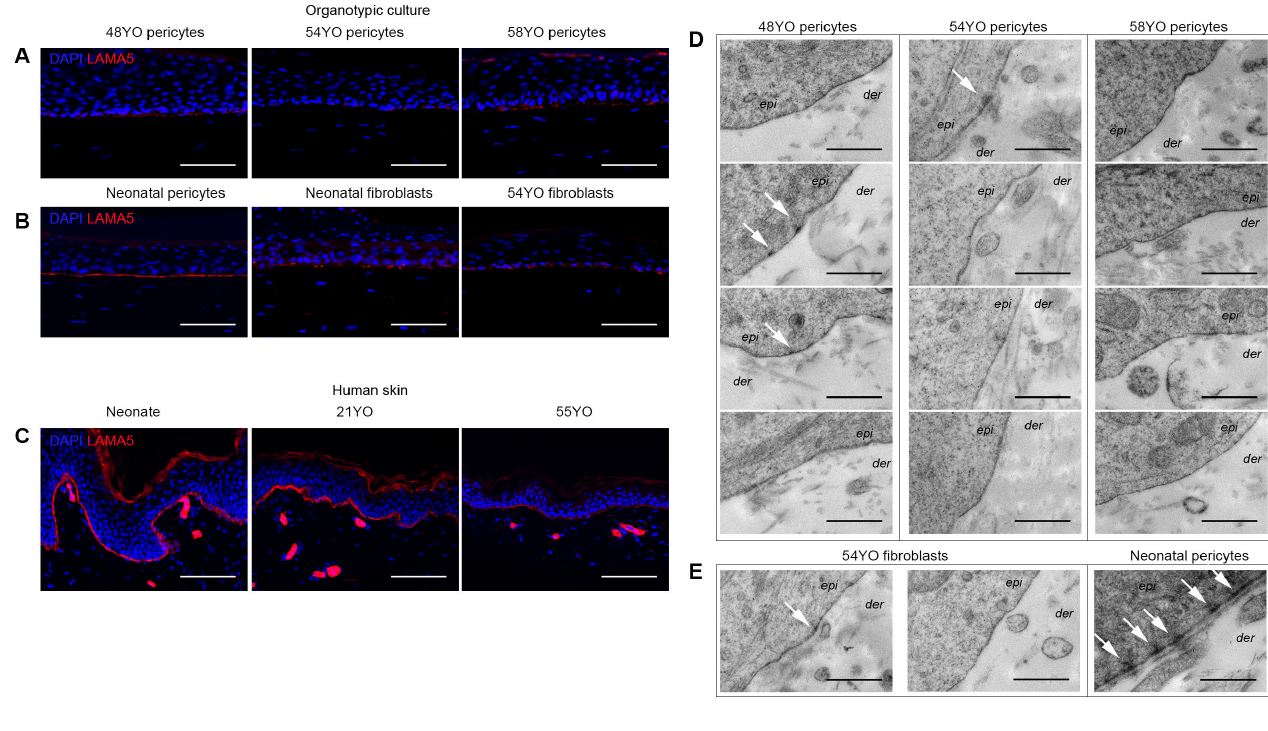
Figure 4. Aged pericytes do not promote LAMA5 deposition nor basement membrane/hemi-desmosome assembly at the dermal–epidermal interface in OCs. ( A – C ). LAMA5 immunostaining (red fluorescence; nuclei blue) in OCs seeded with aged 48–58 yo ( A ) versus neonatal pericytes; or neonatal versus aged fibroblasts ( B ); and neonatal versus 21 yo or 55 yo skin tissue in situ ( C ). ( D , E ). Quadruplicate transmission electron micrographs of the dermal–epidermal junctions of OCs illustrating the absence of basement membrane/hemi-desmosome assembly in OCs seeded with aged 48–58 yo skin pericytes ( D ). Similarly, aged 54 yo fibroblast co-cultures did not exhibit basement membrane assembly (( E ), left panels) whereas neonatal pericytes did (( E ), right panel). Epi = epidermis; der = dermis; white arrows indicate rare initiation of hemi-desmosomes in cultures with aged pericytes ( D ), fibroblasts ( D ) as compared to abundant hemi-desmosomes in cultures with neonatal pericytes (( E ), right panel). Scale bar: 100 µ m ( A – C ); 0.5 µ m ( D , E